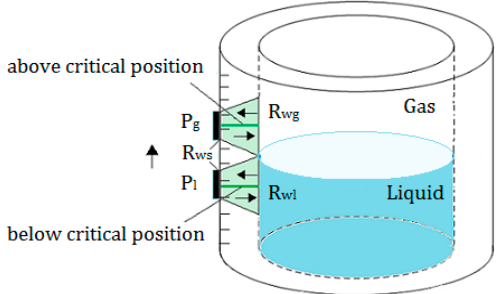
Figure 1. The measurement principle: R wg represents the reflection coefficient at the inner surface above the liquid level; R wl is the reflection coefficient below the liquid level. R ws represents the reflection coefficient at the outer surface of the container wall. P g and P l are the sound pressure relating to the echoes reflected by the inner surface of the container.